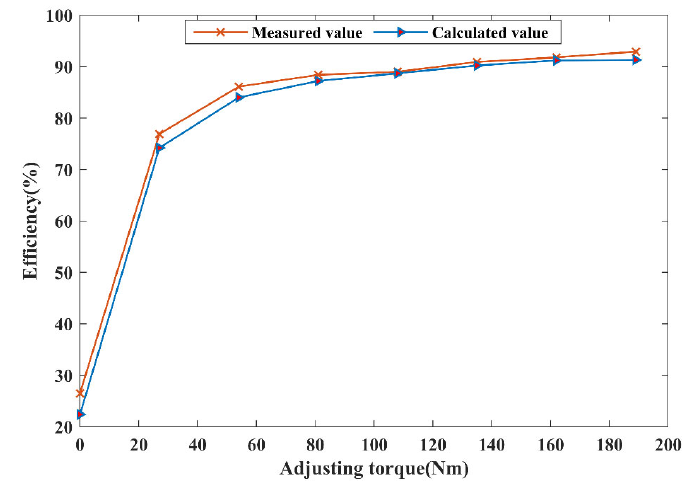
Figure 20. Variation of efficiency with adjusting torque.